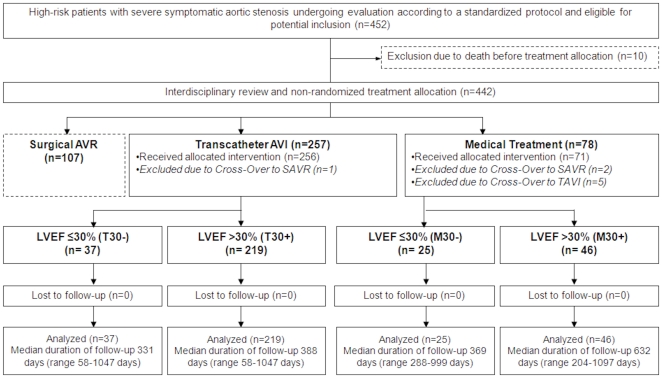
Patient flow according to CONSORT statement.